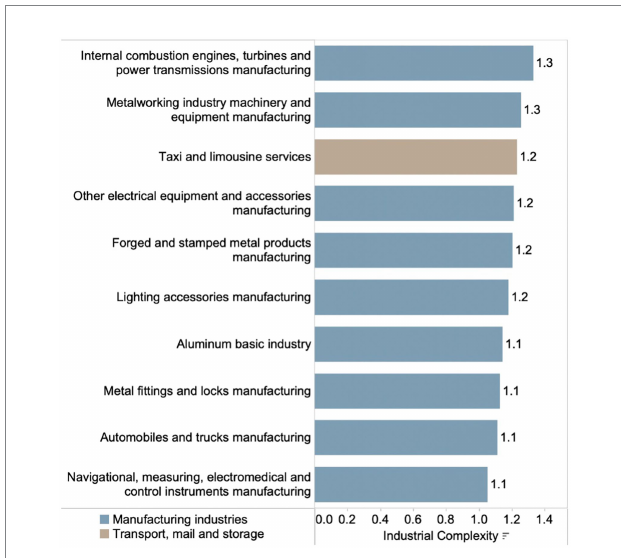
FIGURE 5 Top 10 industries with greater complexity and specialization of the MAQ. Own elaboration based on Economic Censuses 2019 (INEGI).